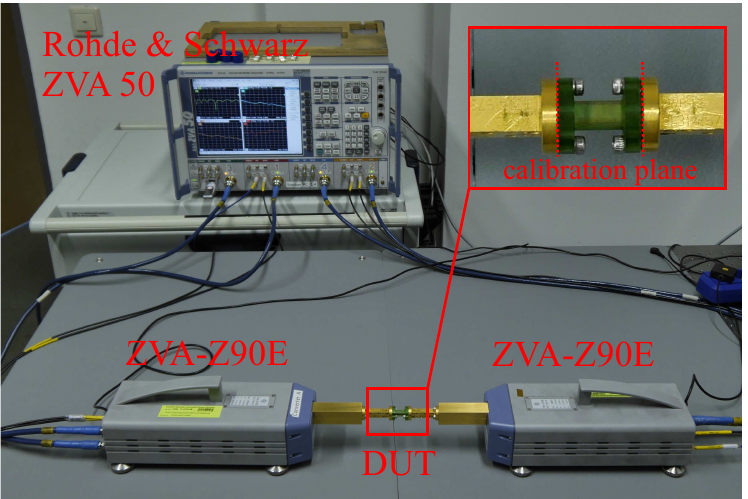
Figure 8. Photography of the measurement setup for determining the scattering parameters of the fabricated waveguides.